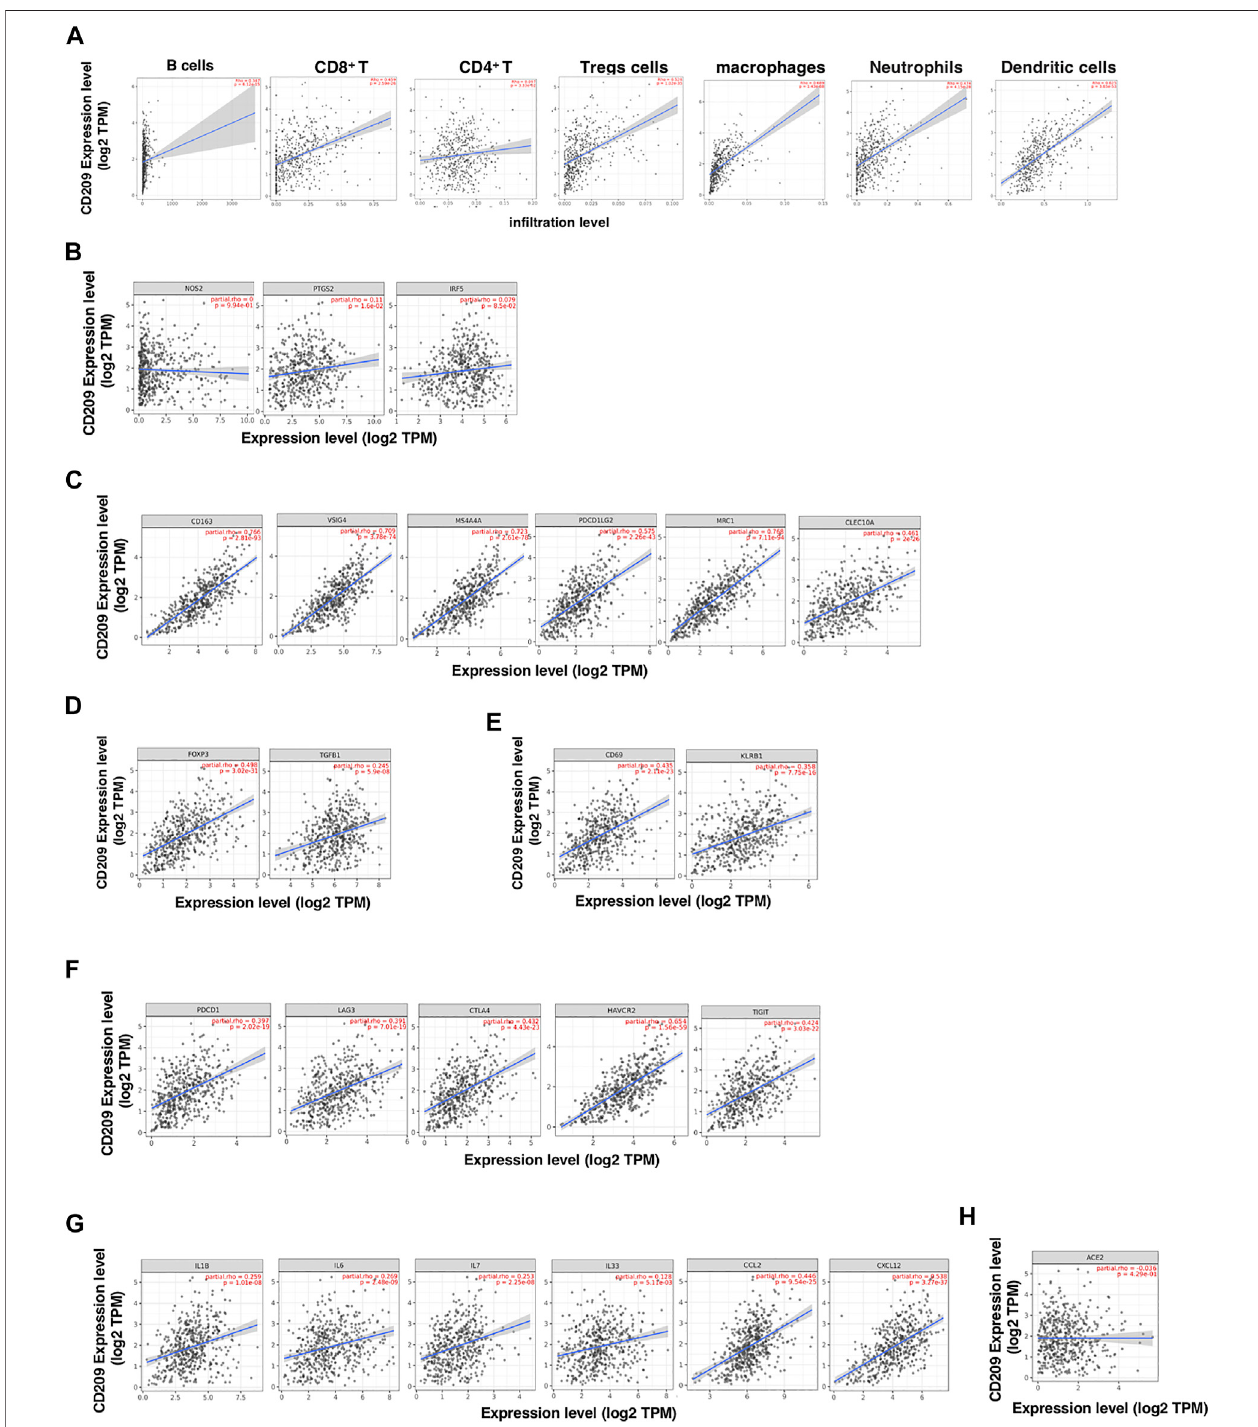
FIGURE 6 | CD209 promotes the in fi ltration of immune cells and the release of cytokines in lung squamous cell carcinoma (LUSC) analyzed with TIMER. (A) Correlation of CD209 expression with the in fi ltration levels of different immune cells including B cells, CD8 + T, CD4 + T, Tregs, macrophages, neutrophils, and dendritic cells in LUSC analyzed with TIMER. (B – E) Scatter plots of correlations between CD209 expression with gene markers of (B) M1 macrophages, (C) M2 macrophages, (D) regulatory T cells, and (E) memory T cells in LUSC. (F) Scatter plots of correlations CD209 expression and T-cell exhaustion markers. (G) Scatter plots of correlations CD209 expression and in fl ammatory cytokines and chemokines. (H) Correlation of CD209 expression with ACE2 in LUSC. CD209 was used for the y -axis with gene symbols and on the x -axis, related marker genes are represented as gene symbols. The gene expression level was displayed using log2 TPM. Abbreviation: ACE2, angiotensinI-converting